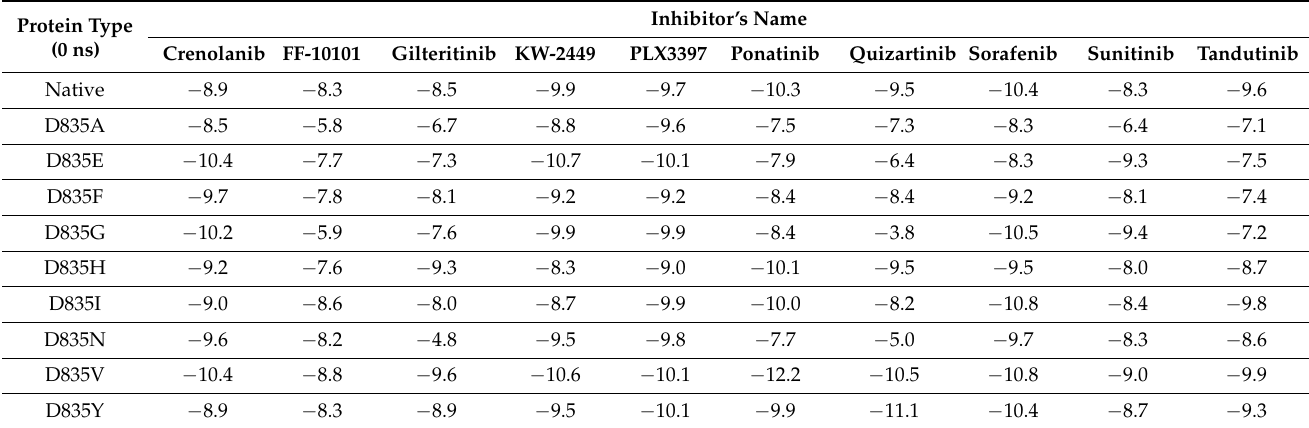
The average binding affinity between the native FLT3 protein and crenolanib inhibitor was found to be − 8.9 kcal/mol. Whereas, the average binding energies of mutant (D835A, D835E, D835F, D835G, D835H, D835I, D835N, D835V, and D835Y) FLT3 proteins and the respectively (Table S1). The FF-10101 inhibitor has an average binding energy with the native and mutant FLT3 proteins of − 8.3, − 5.8, − 7.7, − 7.8, − 5.9, − 7.6, − 8.6, − 8.2, − 8.8, and − 8.3 kcal/mol, respectively (Table S2). The gilteritinib inhibitor has average binding energies mutant FLT3 proteins, respectively (Table S3). The average binding energies of the KW-2449 inhibitor with native and mutant FLT3 are − 9.9, − 8.8, − 10.7, − 9.2, − 9.9, − 8.3, − 8.7, − 9.5, − 10.6, and − 9.5 kcal/mol, respectively (Table S4). The PLX3397 inhibitor has an average